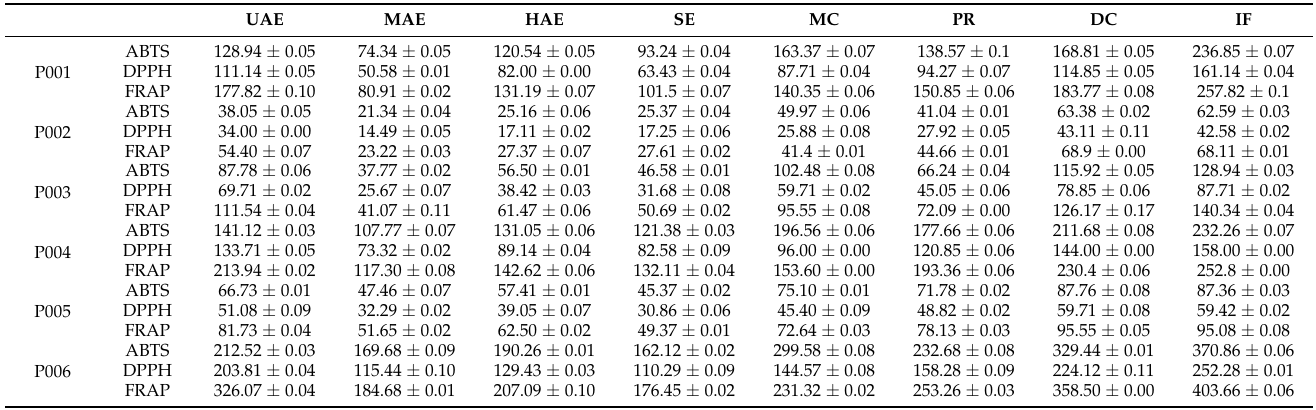
Table 2. Antioxidant properties of MAP extracts obtained using different conventional and advanced extraction